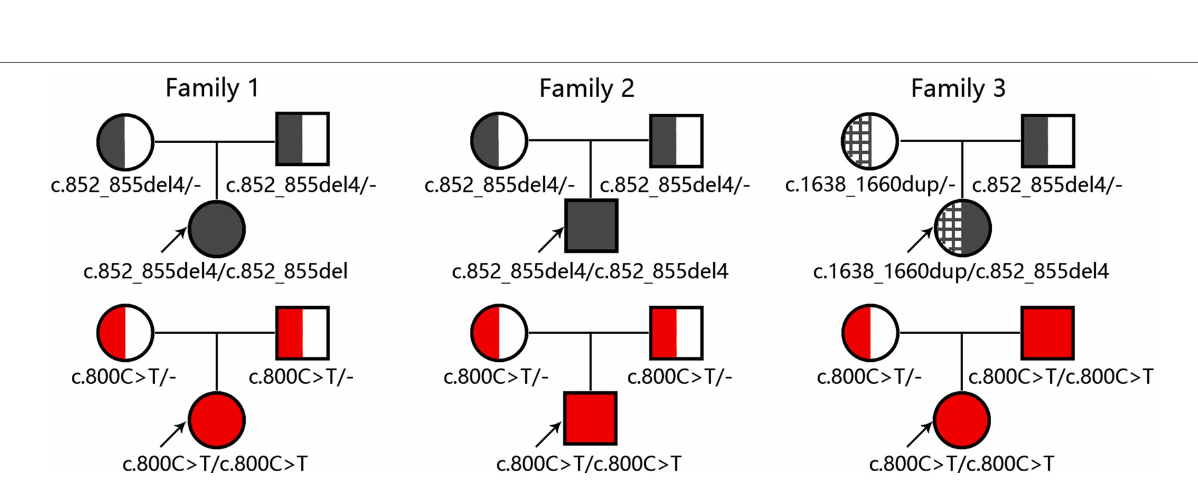
FIGURE 2 | Genotyping results by Sanger sequencing analysis in the three unrelated families. On SLC25A13 analysis (A) , patients 1 and 2 were both homozygotes of the c.852_855del4 mutation while patient 3, a compound heterozygote of the mutations c.852_855del4 and c.1638_1660dup. The parents of patients 1 and 2 as well as the father of patient 3 were all carriers of the c.852_855del4 mutation, while the mother of patient 3, a carrier of c.1638_1660dup. On SLC10A1 analysis (B) , patients 1, 2, and 3 as well as her father were all homozygotes, while the parents of patients 1 and 2 and the mother of patient 3, all carriers, of the variant c.800C >